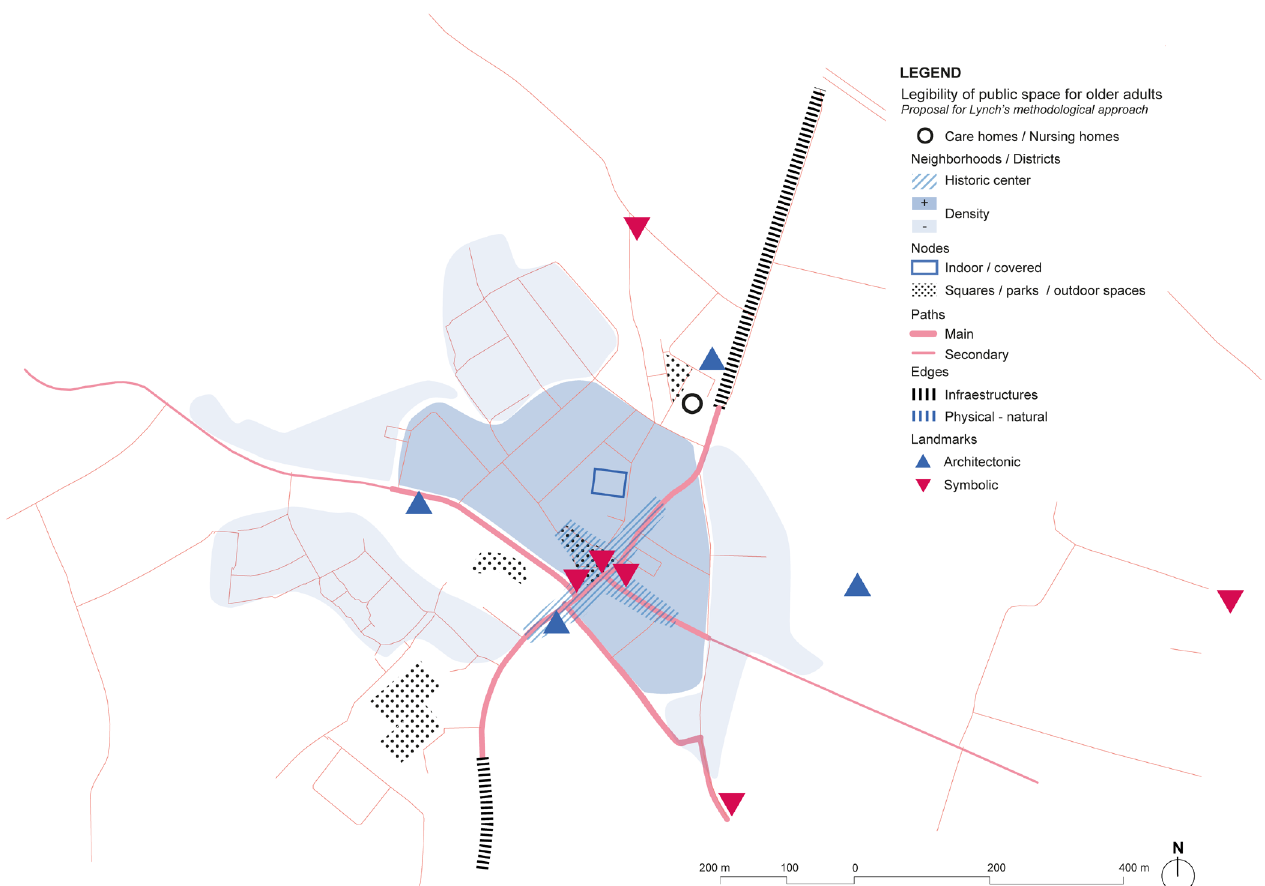
Figure 13. De Weister center and its surroundings’ scheme based on Lynch’s theory. Source: Own elaboration.